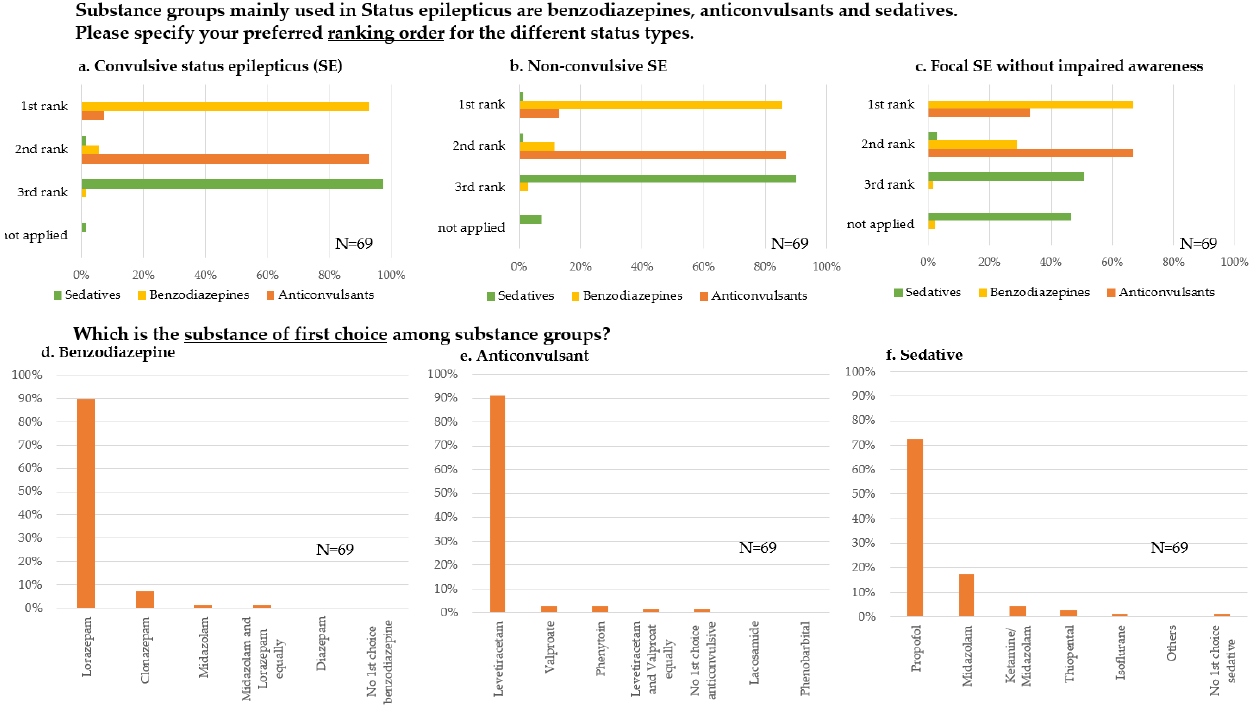
Figure 3. Pharmacotherapy in status epilepticus (SE). ( a – c ) Ranking order of substance groups in convulsive SE ( a ), non-convulsive SE ( b ) and focal SE ( c ). ( d – f ) Substance of first choice among benzodiazepines, anticonvulsants and sedatives. Data are displayed as percentage of survey participants answering this question. N = number of respondents; SE = status epilepticus.